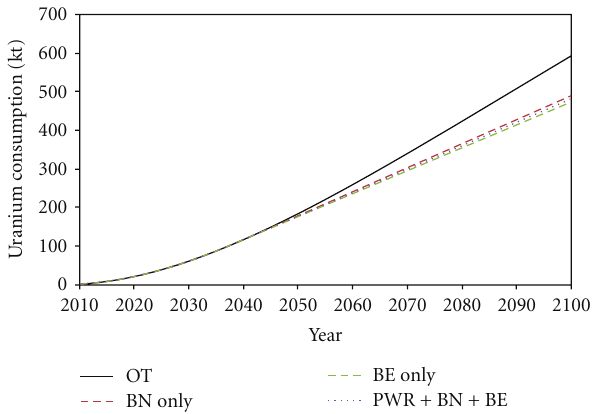
Figure 7: Uranium consumption.